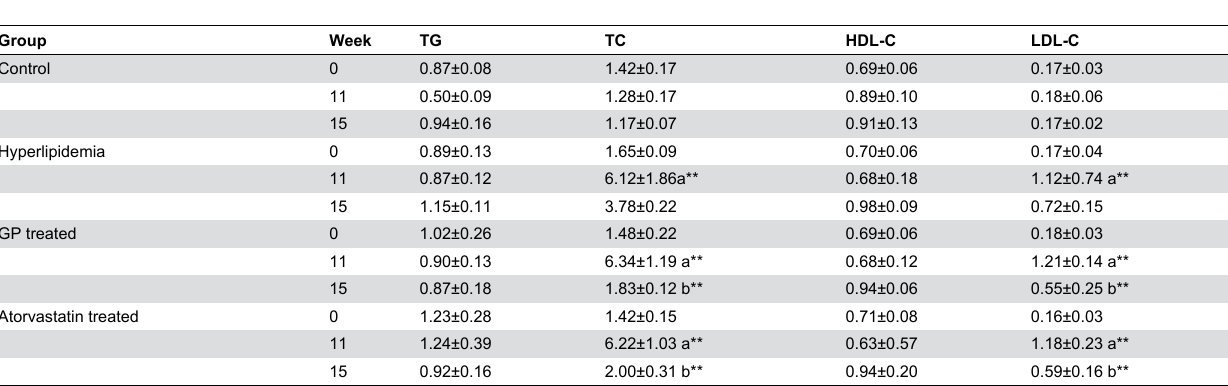
Table 1. Plasma lipid levels of rats from the four groups. (x±s, n=8,